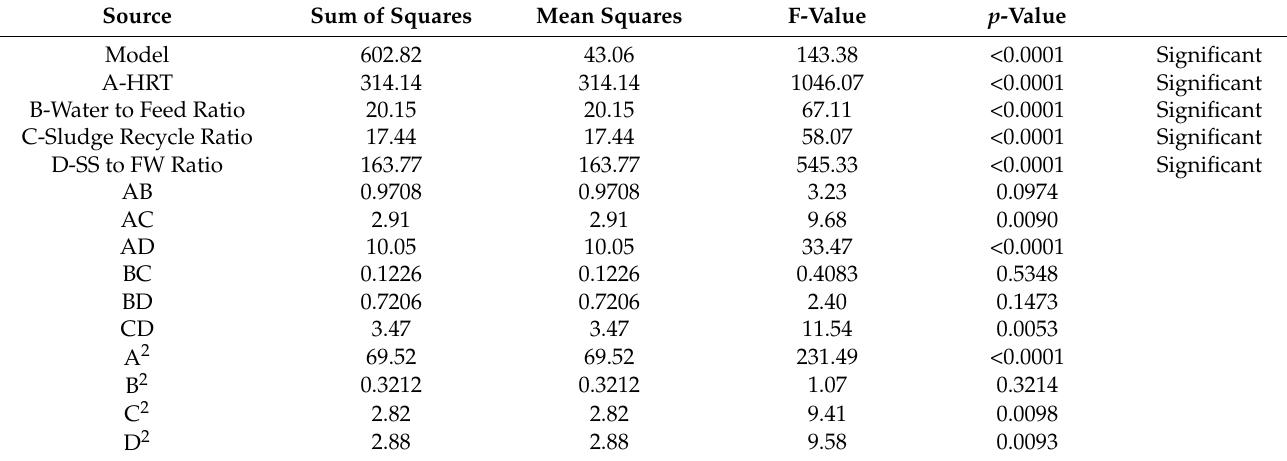
Table 5. ANOVA analysis for COD removal efficiency response.